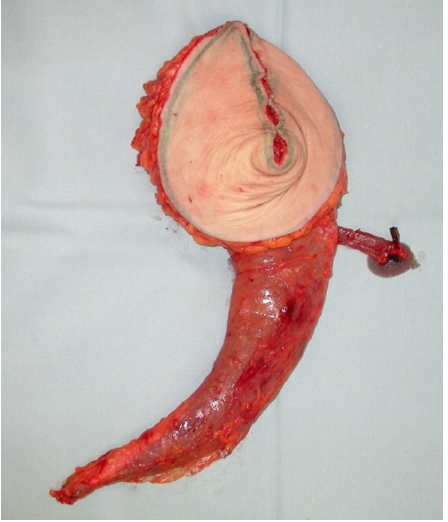
Figure 10. TMG flap after folding to generate an implant like flap shape.